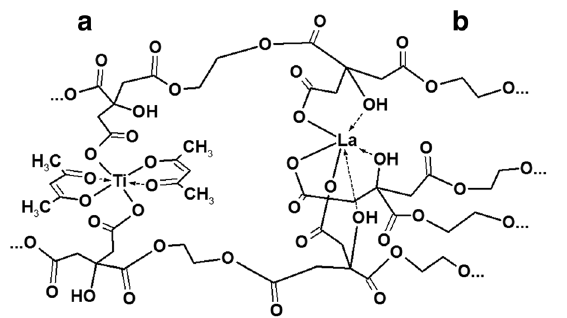
Fig. 3 Hypothetical structure of the heterometalic La3+ ( a ) and Ti4+ ( b ) — polymeric complex fragments derived from 13C-NMR and FT-IR